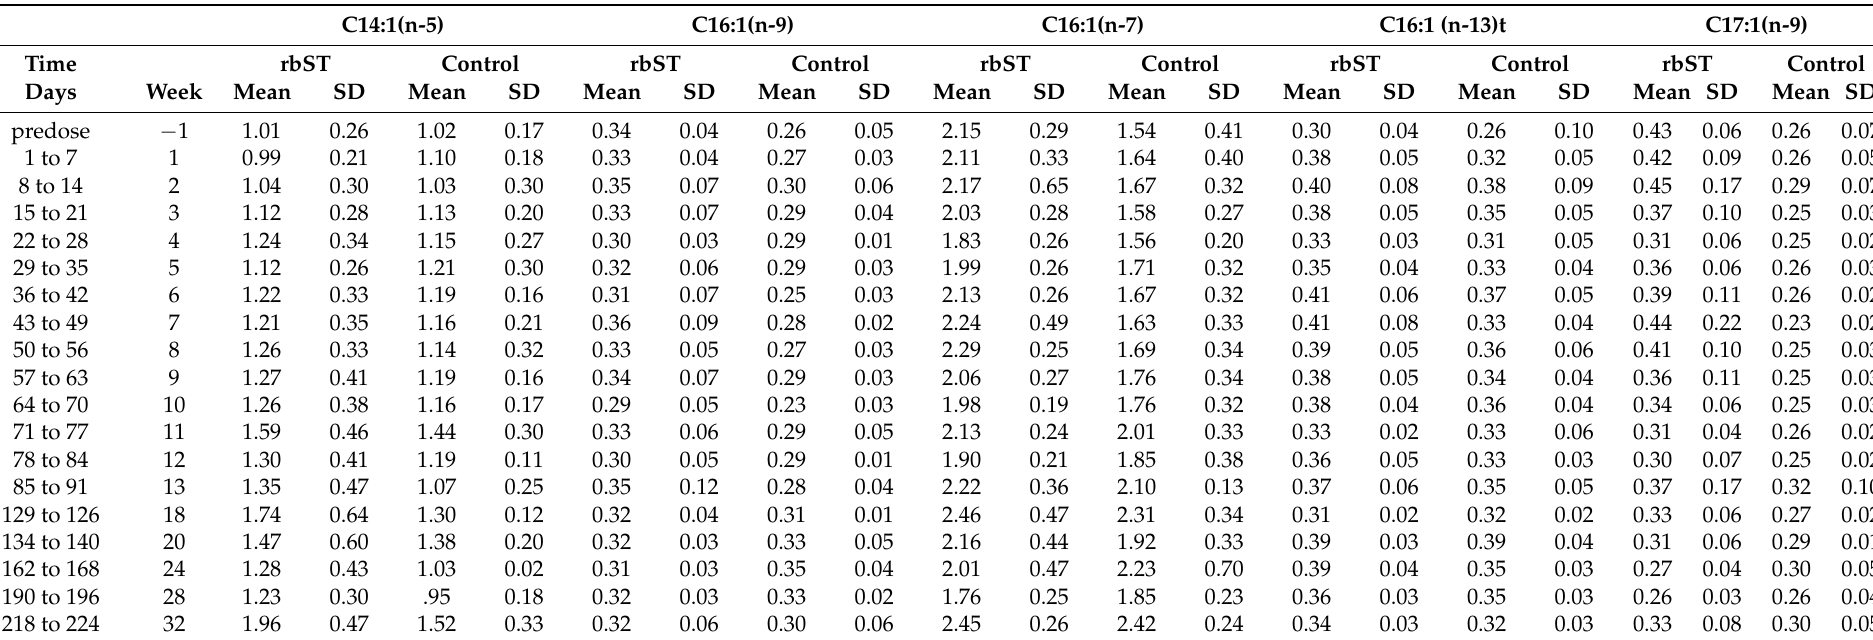
Table 4. Monounsaturated fatty acids with 14, 16, or 17 carbons in milk (% w / w of total fatty acids) obtained from cows treated with recombinant bovine somatotropin (rbST) ( n = 6) and from control animals ( n = 3) at different time points selected over the course of 37 weeks (8 injections of Lactotropina manufactured by Elanco, Eli Lilly,